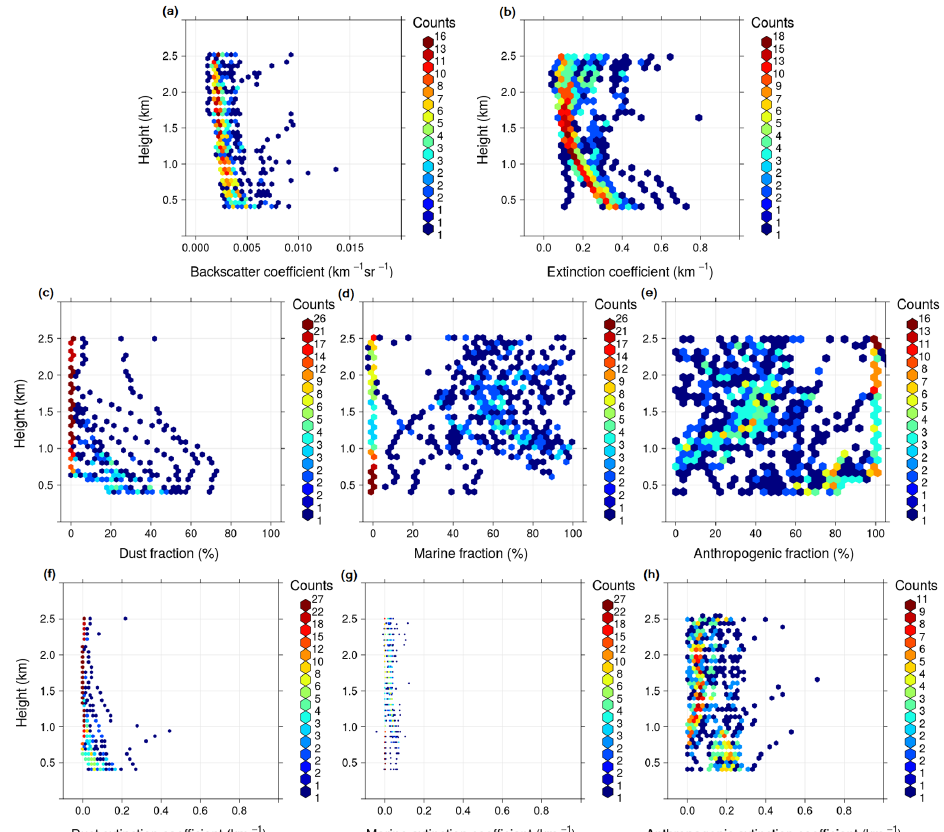
Figure 17. Occurrence distributions of ( a ) total aerosol backscatter coefficient, ( b ) total aerosol extinction coefficient, ( c ) dust fraction in total aerosol backscatter coefficient, ( d ) marine fraction in total aerosol backscatter coefficient, ( e ) combustion fraction in total aerosol backscatter coefficient, ( f ) dust extinction coefficient, ( g ) marine extinction coefficient, ( h ) combustion extinction coefficient. Color indicates occurrence frequency. Table 2. The mean occurrence frequency of presence, predominance (fraction in total aerosol backscat- ter coefficient is bigger than 50%) and absence in total aerosol for marine, combustion and mineral dust aerosols throughout whole investigated profiles are